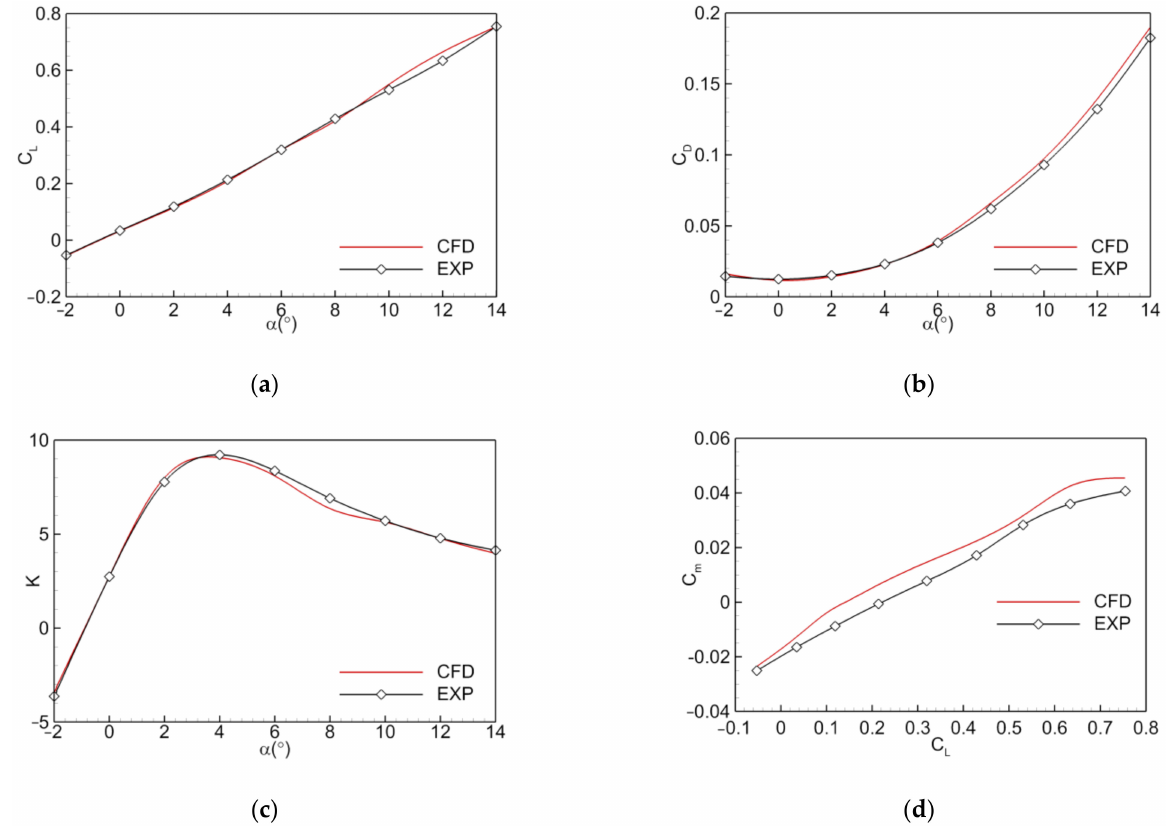
Figure 36. Comparison of the wind tunnel and numerical results on the trimmed configuration. Ma = 0.85, Re = 7.1 × 10 6 , α = − 2 ◦ ∼ 14 ◦ , ∆ α = 2 ◦ . ( a ) Lift coefficient; ( b ) Drag coefficient; ( c ) Lift to drag ratio; ( d ) Pitching